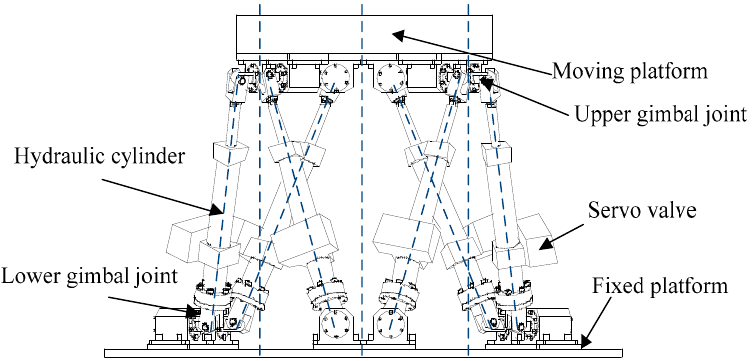
Figure 1. Schematic diagram of the 6-DOF parallel